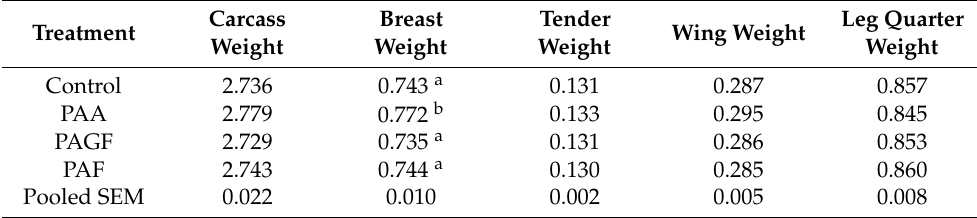
Table 3. Processing part averages (kg) of broilers fed either a control diet or control diet with 5 mg/bird/day of phosphatidic acid added from d0–42 (PAA), d15–42 (PAGF), d29–42 (PAF). Treatment